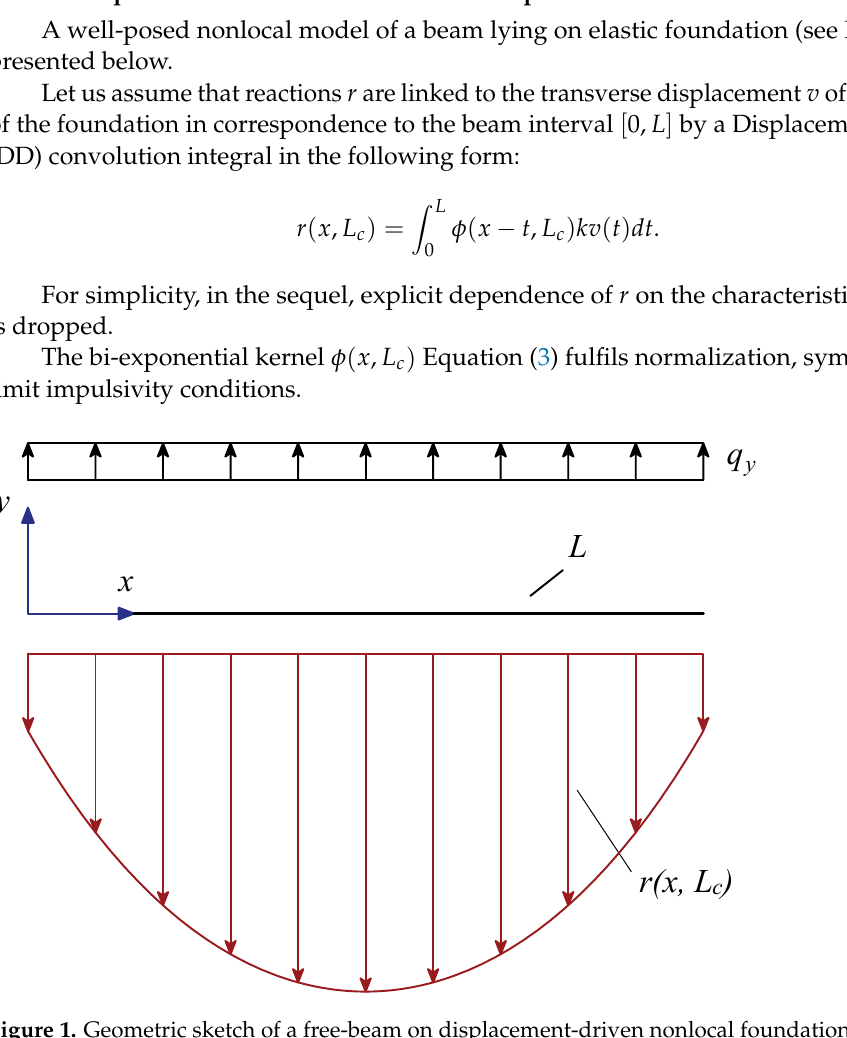
Figure 1. Geometric sketch of a free-beam on displacement-driven nonlocal